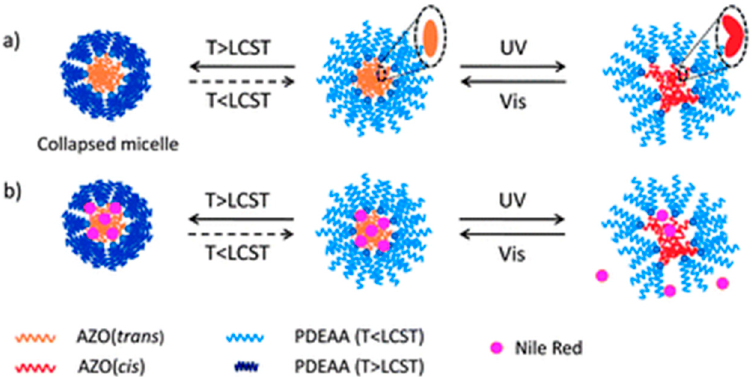
Figure 12. Representation of ( a ) temperature and UV-induced morphological response of PAzo-PDEAA 3 micelles and ( b ) the corresponding proposed Nile Red release. Reprinted with permission from reference [46]. Copyright 2013 Royal Society of Chemistry.